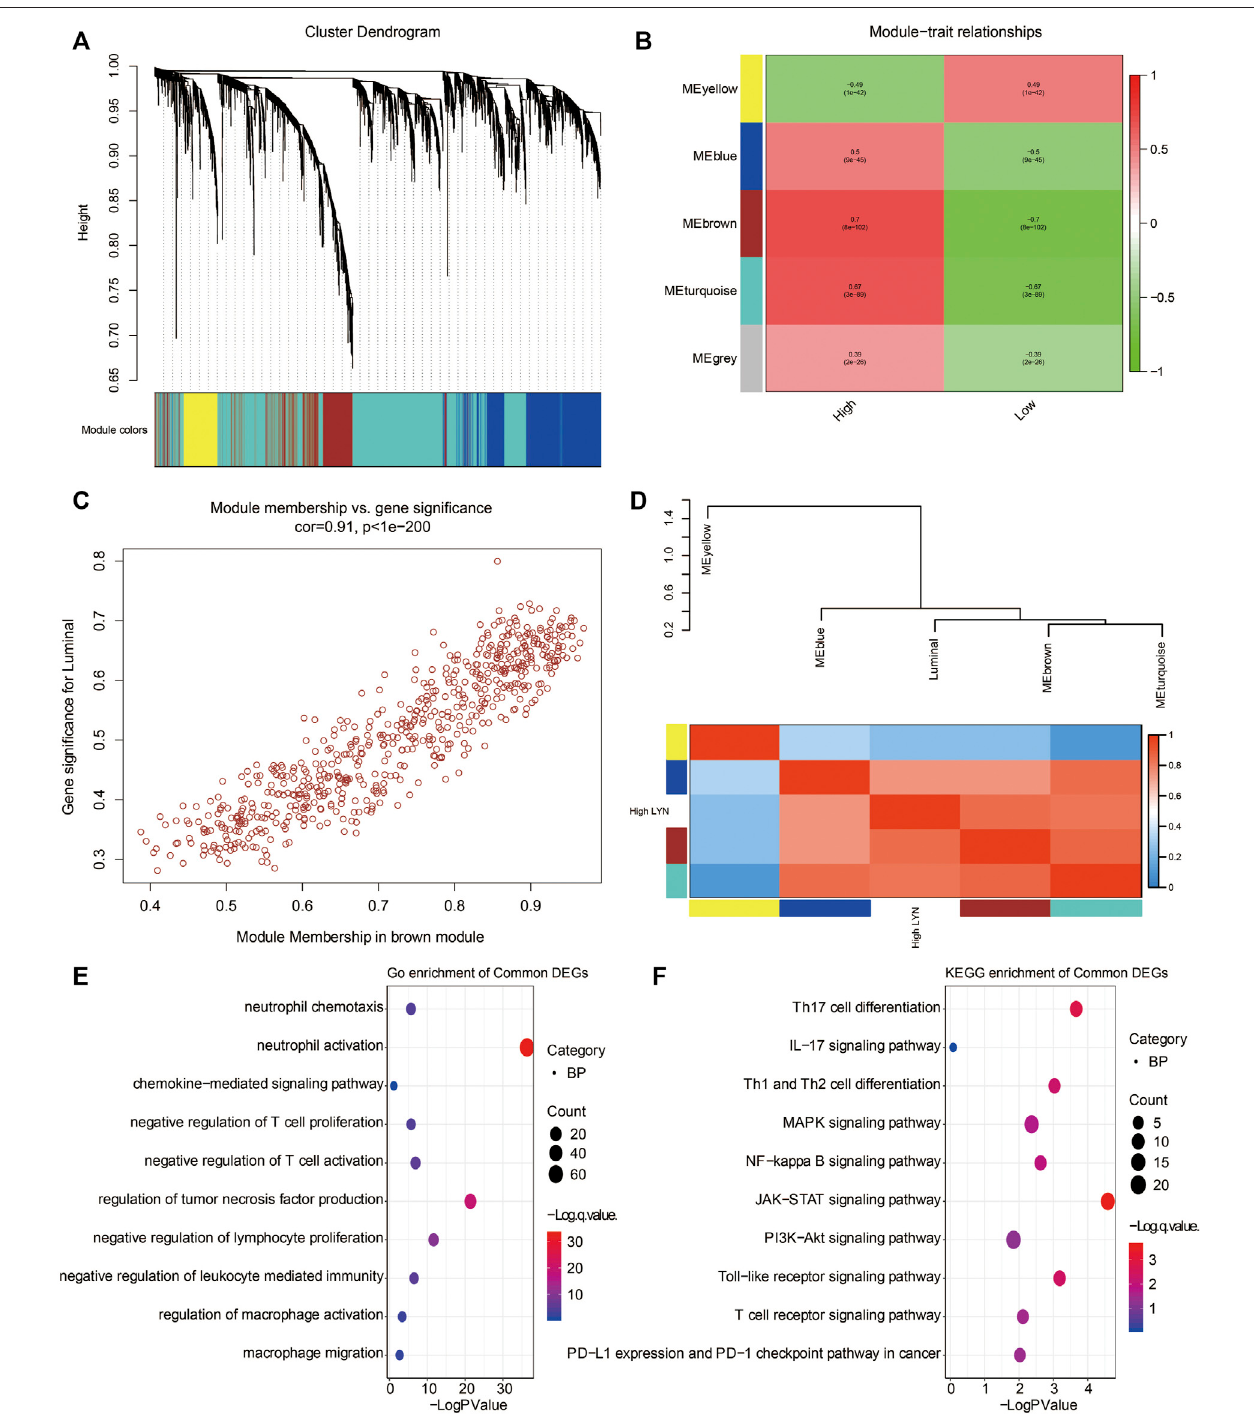
FIGURE9| WGCNA exploring LYN-related genemodule (A) .WGCNA wasperformed toidentify fi vemodules (B) .Fourmodules(nongrey)wereidenti fi ed withthe brownmoduleshowingthehighestcorrelation( r (cid:1) 0.7, P (cid:1) 8e-102)withhighLYNexpression (C) .Thegenesigni fi cancehighlycorrelatedwithmodulemembershipofthe genes in the brown module (D) . The clustering results of the identi fi ed modules (E) . GO enrichment analysis of the genes extracted from brown module (F) . KEGG enrichment analysis of the genes extracted from brown module.